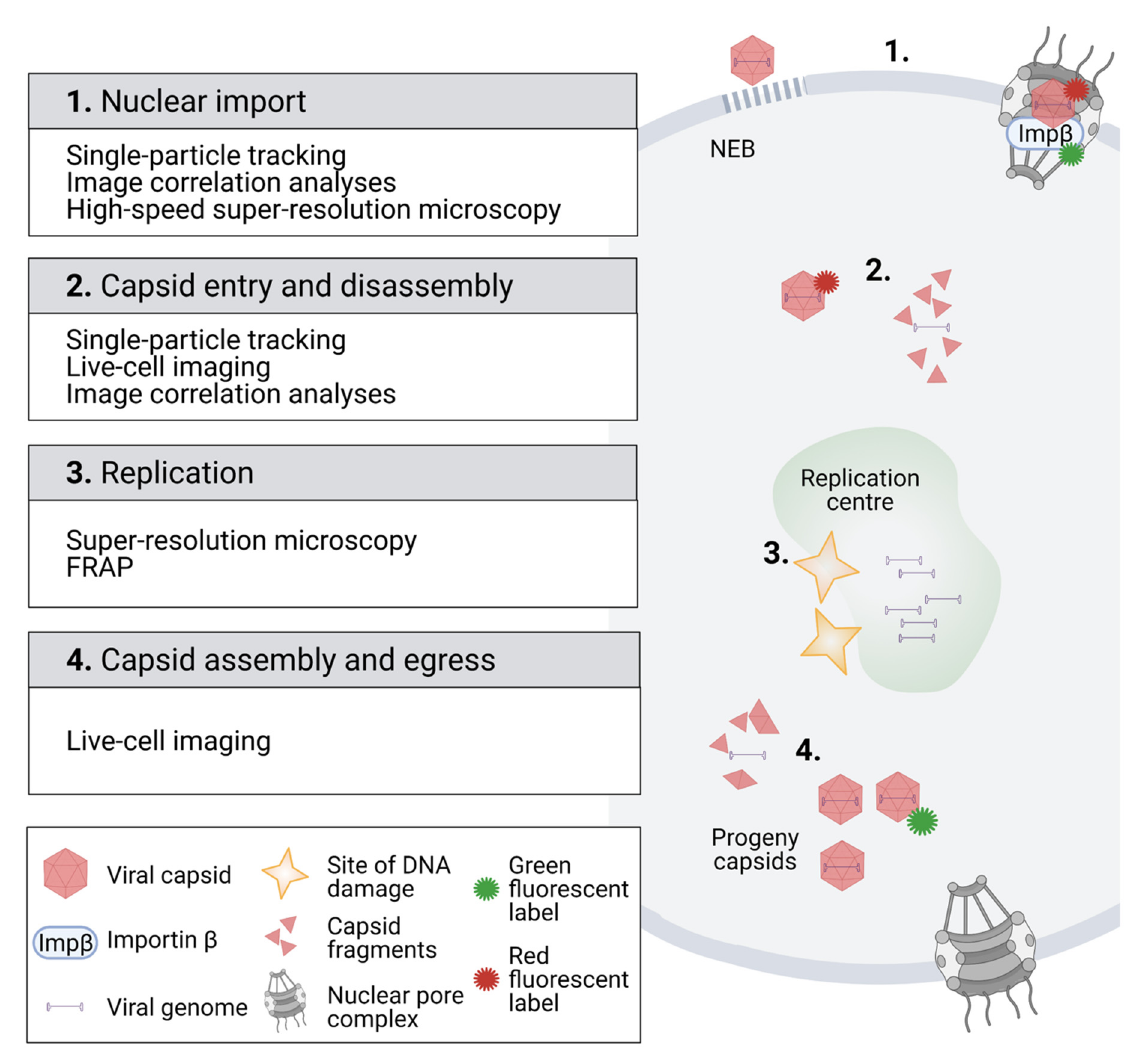
Figure 1. Imaging of viruses in the nucleus of infected cells.